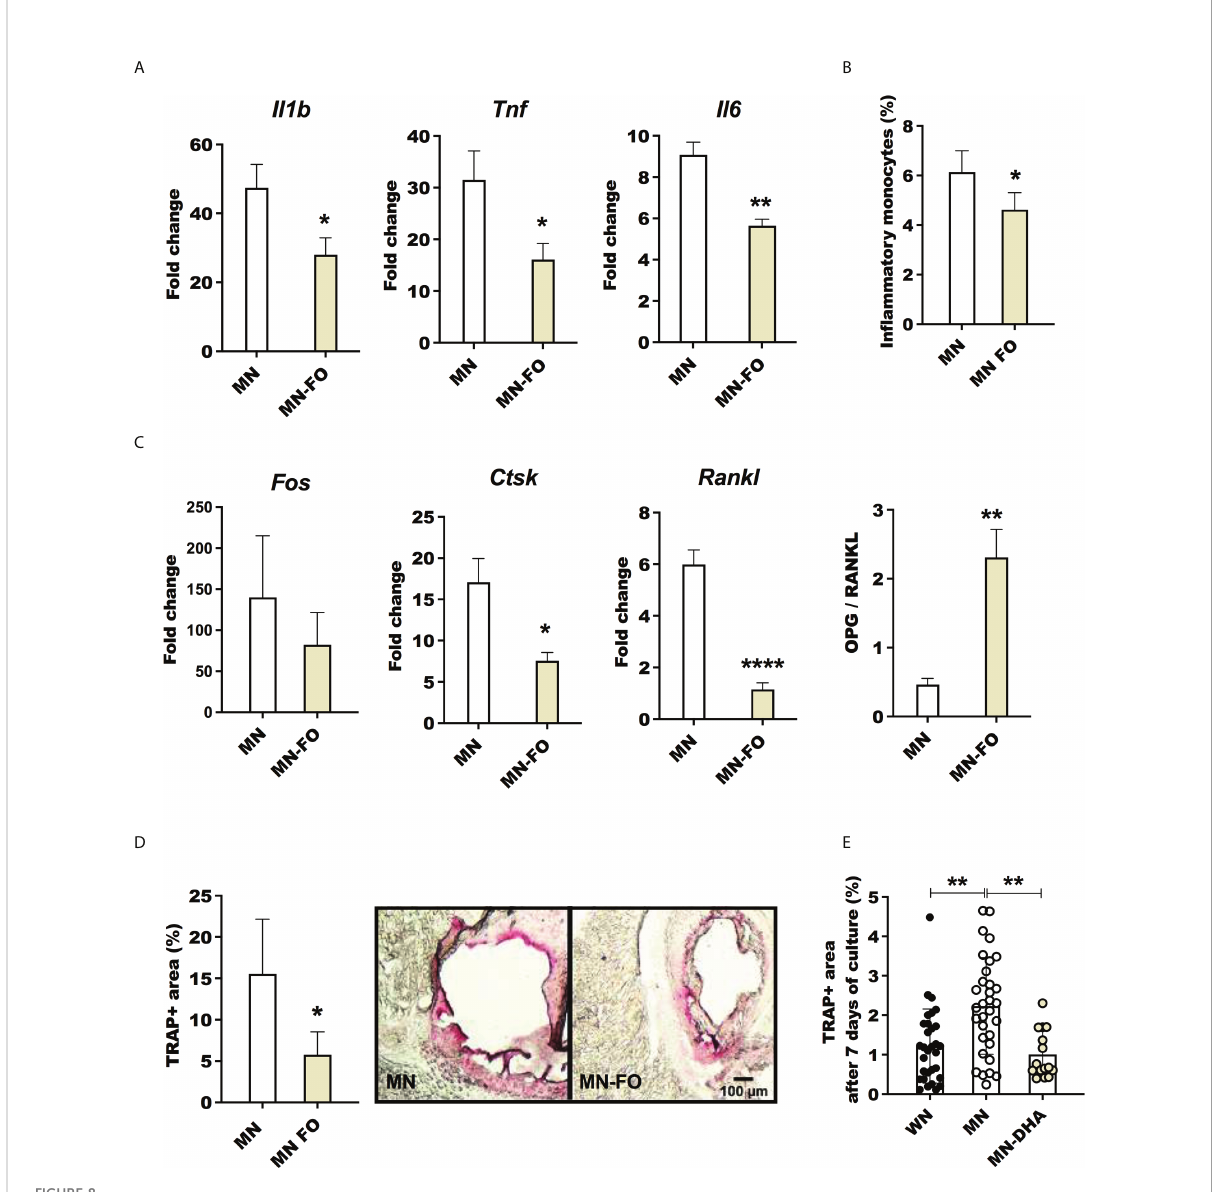
FIGURE 8 Fish oil supplementation decreases in fl ammation and osteoclast activation in malnourished mice following in fl ammatory challenge. Malnourished were mice fed with the standard nutrient de fi cient diet containing corn oil (MN) or with a nutrient de fi cient diet in which the corn oil was replaced by fi sh oil (MN-FO). Both groups of mice were challenged with LPS and the bone marrow isolated 24 hrs later. (A) Expression of interleukin-1 b ( Il1b ), tumor necrosis factor ( Tnf ) and interleukin-6 ( Il6 ) in bone marrow. Determined by qRT-PCR and expressed as the fold- change over unchallenged mice from the same group. (B) Percentage of in fl ammatory monocytes (CD11b+Ly6C int/hi Ly6G-CD11c-) relative to total bone marrow cells determined by fl ow cytometry (gated as shown in Supplementary Figure 1E). (C) Expression of genes associated with osteoclastogenesis, Fos , Ctsk and Rankl , and ratio of the expression of Opg / Rankl in the bone marrow. (D) Percentage of area occupied by tartrate-resistant acid phosphatase positive (TRAP+) in sternum cryosections image of a TRAP+ fi eld in the bone marrow (pink area). (E) Percentage of area occupied by TRAP+ osteoclasts after 7 days of differentiation of bone marrow cells from LPS challenged mice, treated ex vivo with the omega-3 fatty acid Docosahexaenoic acid (MN-DHA) or vehicle (MN) and compared with those from well-nourished mice (WN). N=5 mice per group, 2 experiments. *p<0.05,